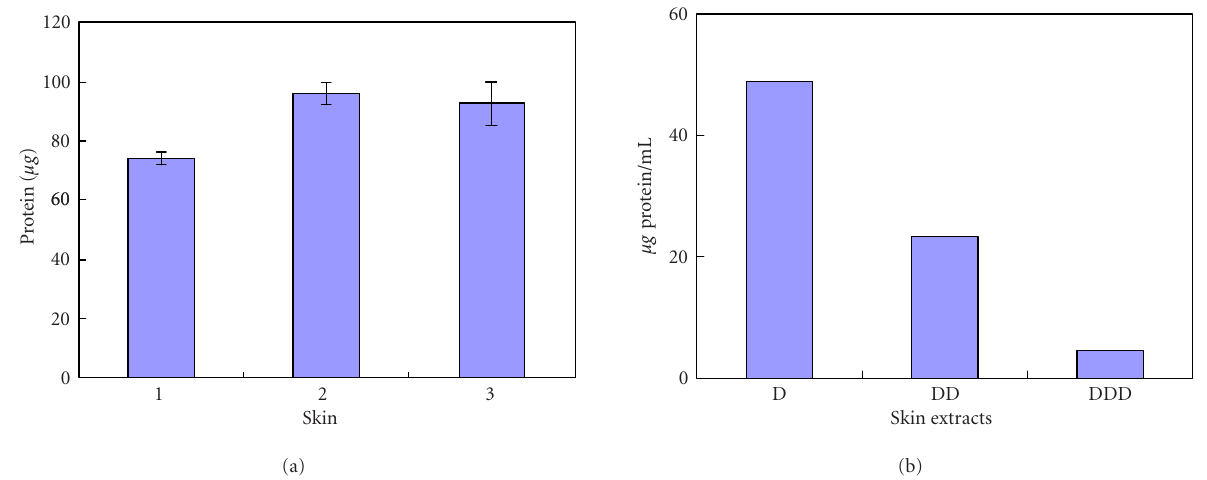
Figure 3. Yields in microgrammes of protein from 3 separate pieces of the same sample of human skin showing the consistent recovery of protein in extract D, each piece having a wet weight of almost 13g. The bars show the mean ± 1 SD of the average protein estimate of 4 determinations.